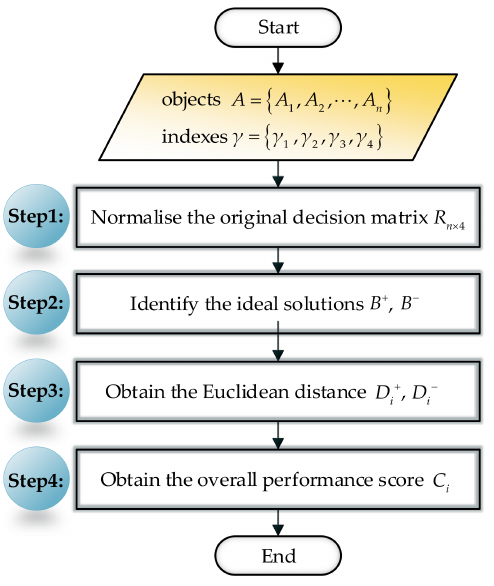
Figure 2. Flow chart of modified TOPSIS